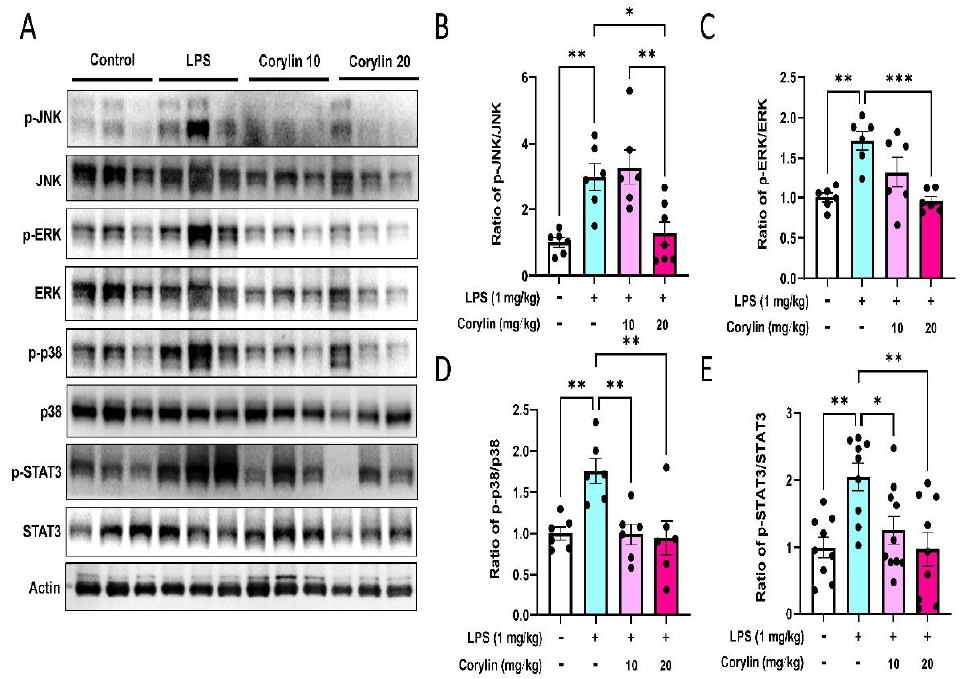
Figure 4. Effects of corylin on the expression and phosphorylation of MAPKs and STAT3 in lung tissues. Expressions of phospho-JNK, JNK, phospho-ERK, ERK, phospho-p38 MAPK, p38 MAPK, phospho-STAT3 and STAT3 were analyzed by Western blot. ( A ) The representative blot of triplicate experiments. Quantitated results of ( B ) phospho-JNK/JNK ratio ( n = 6), ( C ) phospho-ERK/ERK ratio ( n = 6), ( D ) phospho-p38/p38 ratio ( n = 6), and ( E ) phospho-STAT3/STAT3 ratio ( n = 9~10) were shown as mean ± SEM. The relative fold of phosphorylation activity was normalized to untreated samples. (* p < 0.05, ** p < 0.01 and *** p < 0.001 vs. LPS alone).